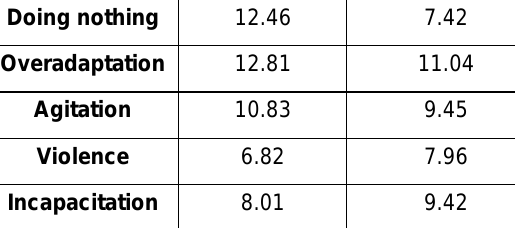
Table 1. Results of the study of school passive behaviours in Poland (source: Pierzchała, 2013) Additionally, the qualitative analysis of student interviews revealed a psychodynamic rationale for the observed passive behaviours. For example, in the student interviews some